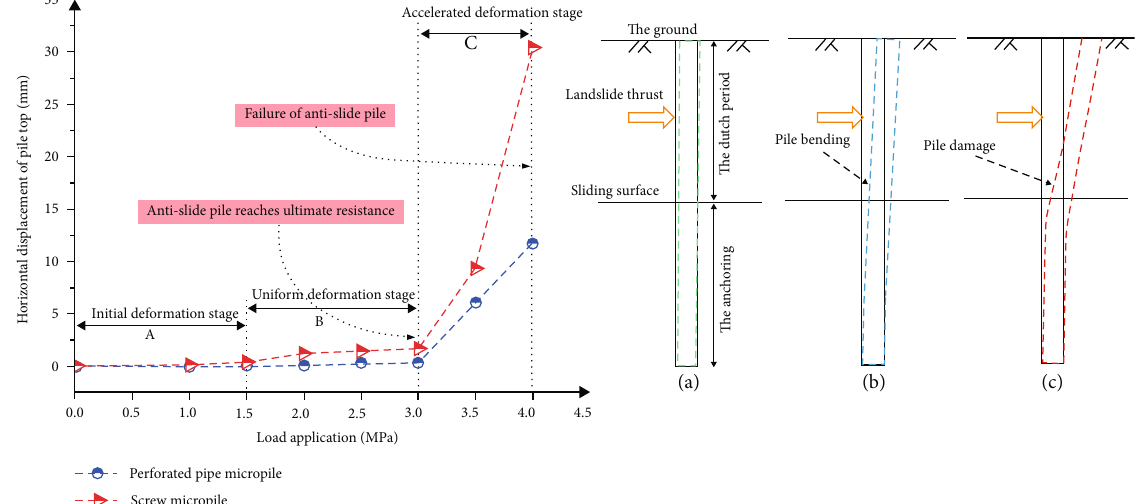
Figure 9: Change of horizontal displacement of pile top and evolution of pile body Figure 9, the deformation process of micro-antislide pile under landslide thrust can be divided into three stages: initial ated deformation stage. Under the small external force, the stress distribution of the rock mass at the back edge of the landslide changes, resulting in tensile cracking deformation.